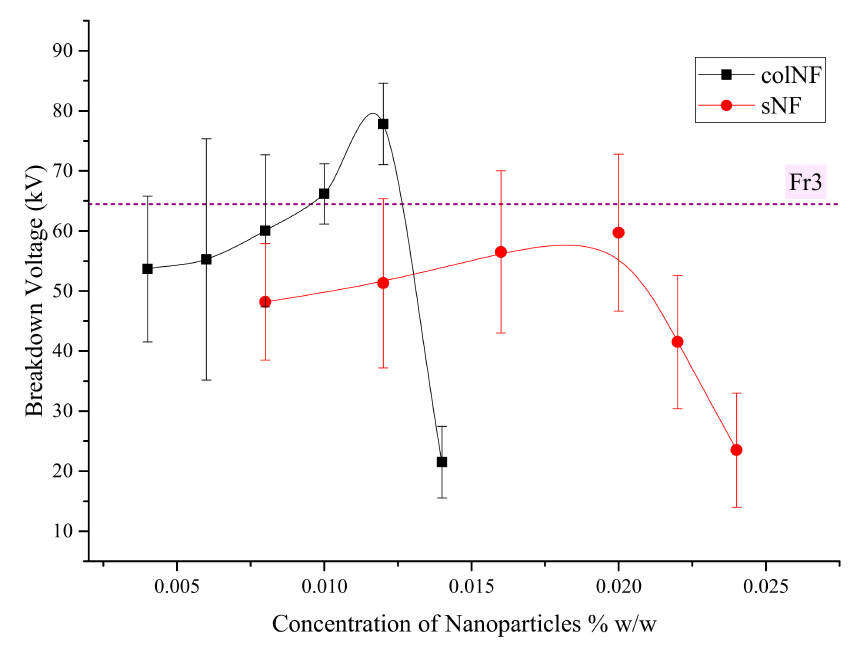
Figure 3. Mean AC breakdown voltage (BDV) versus nanoparticles concentration (colNF and silica NF).